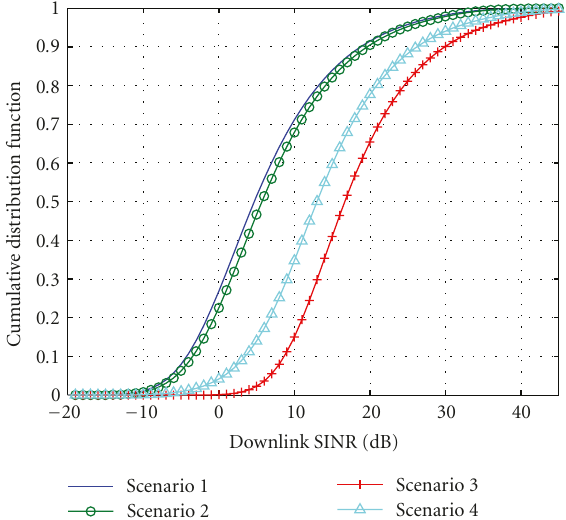
Figure 7: E ff ect of di ff erent wall penetration losses on CDF of SINR (FW method, σ X